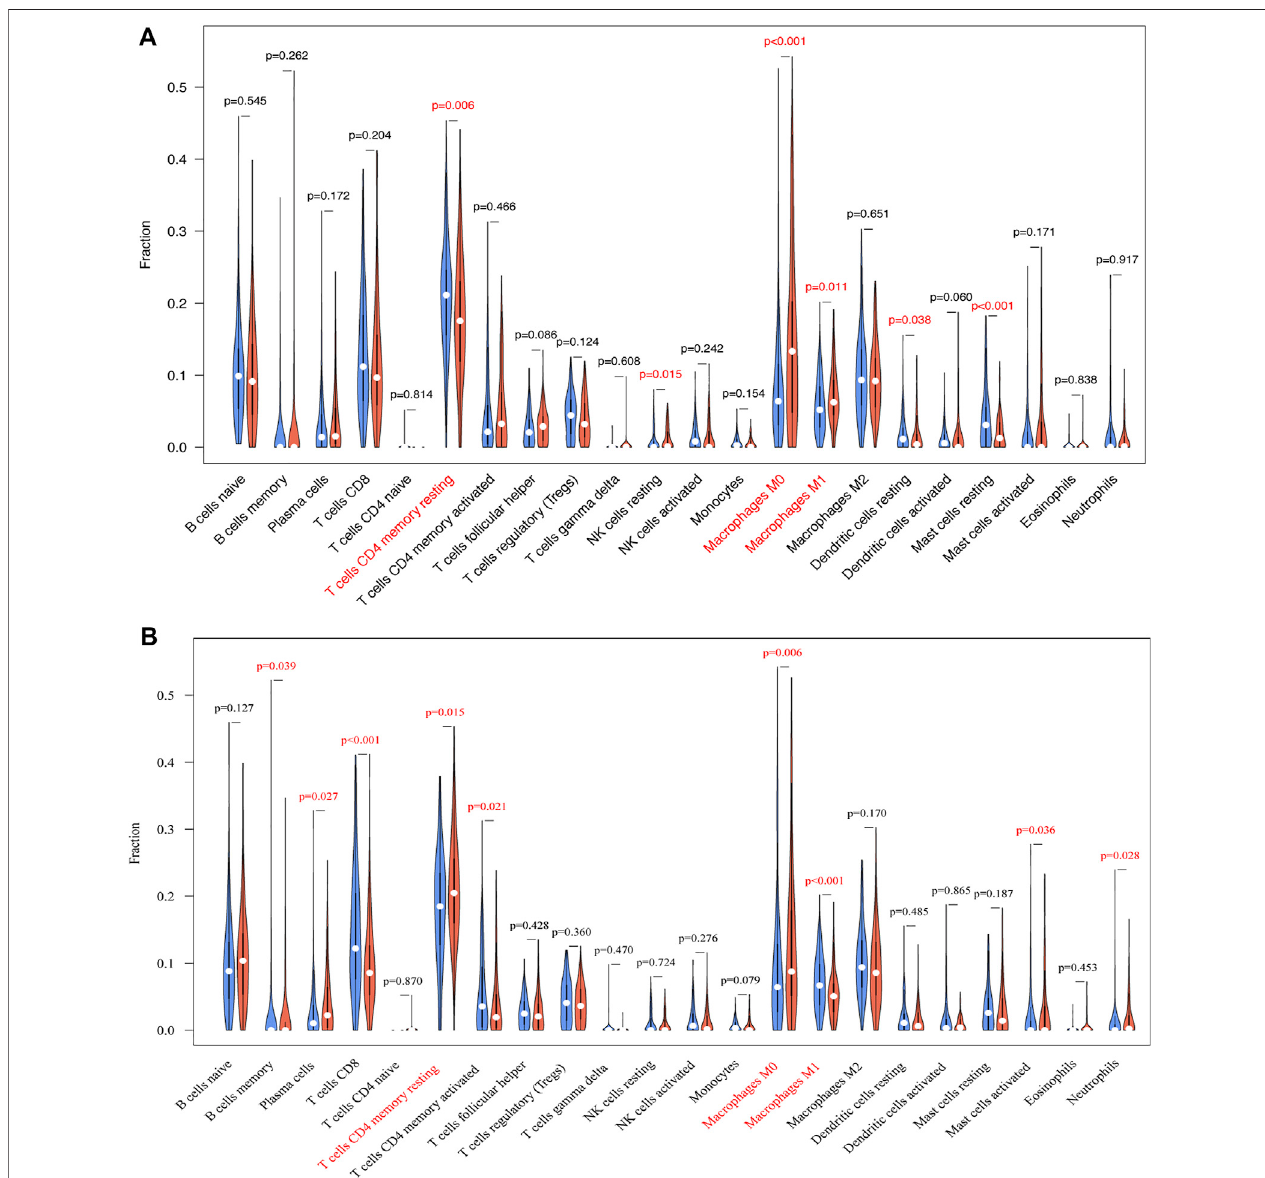
FIGURE 8 | The associations of TRIB3 (A) and FABP1 (B) with immunocyte in fi ltrations in GC were further evaluated.